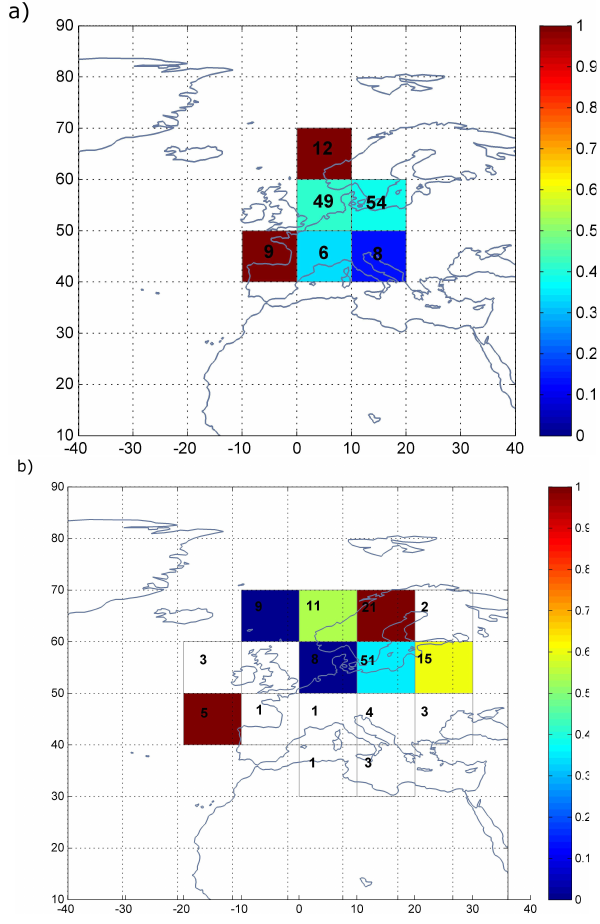
Fig. 2. Frequencies (colour coded from 0–1) of observed particle formation as a function of air mass origins (squares) determined for two chosen back-trajectory calculation times of 24h (a) and 48h (b) . The numbers associated to each square denote the total number of calculated air mass origins assigned to the complete set of EUCAARI flights horizontally divided into equidistant flight seg- ments, for which calculations have been